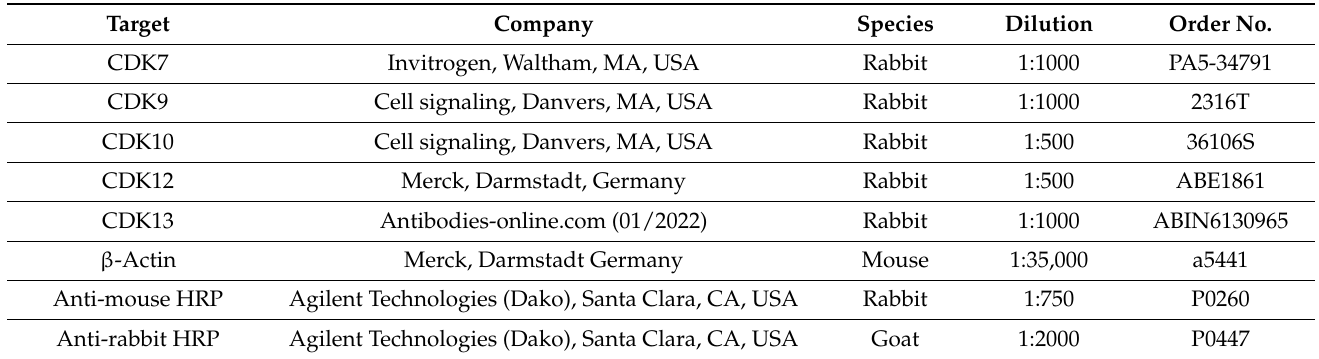
Table 1. Primary and secondary antibodies used in this